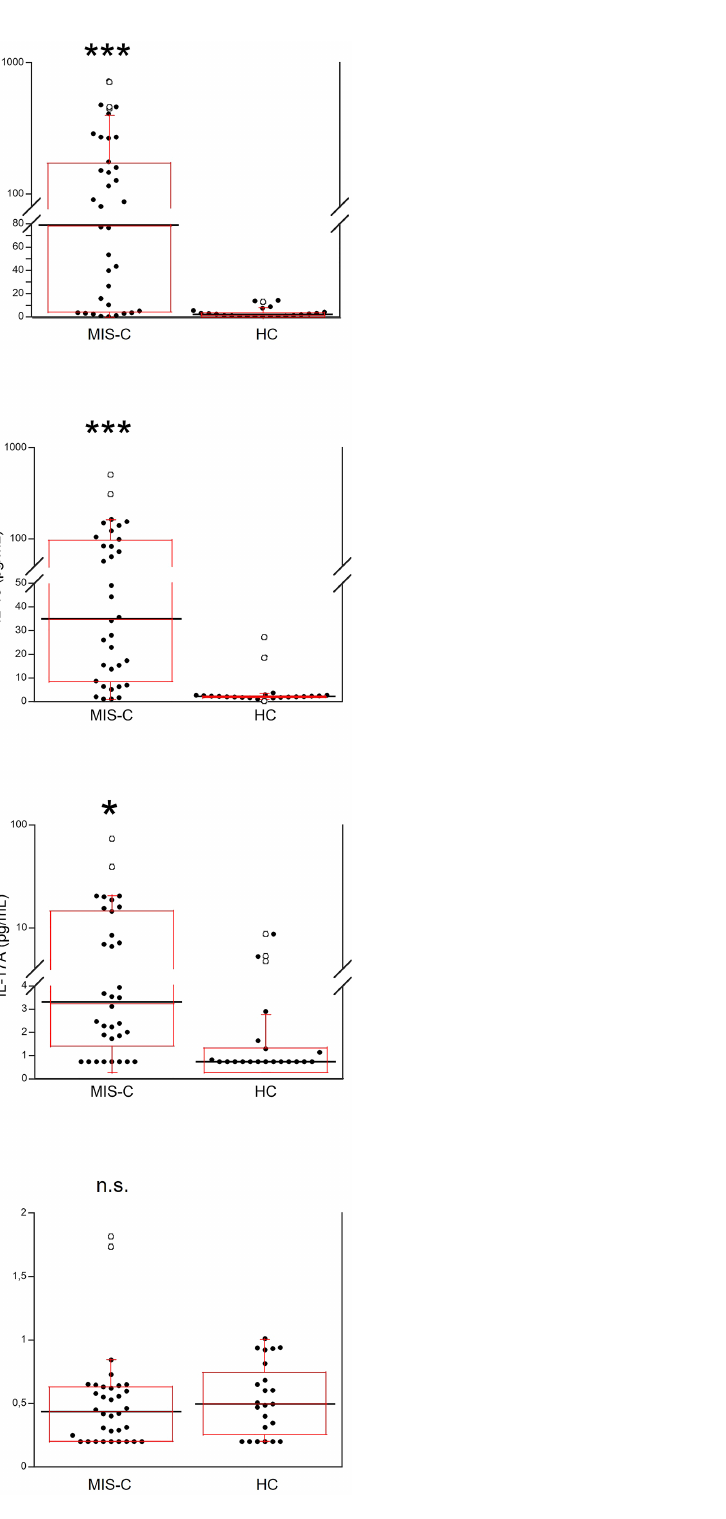
FIGURE 2 Comparison of serum levels of IL-6, IL-10, IL-17A and IL-12p70 in 37 patients with MIS-C and in 24 HC. The black line represents the median value. The red box represents the interquartile range. The blank circles correspond to the outliers and the black circles side by side to these correspond to duplicates *p < 0.01; ***p < 0.0001; n.s.: not signi fi cant (p >